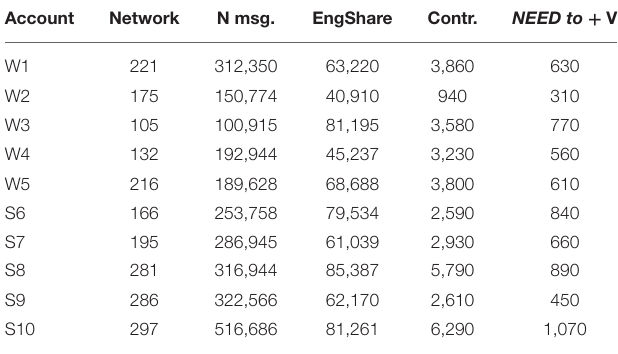
TABLE 2 | Statistics related to the dependent variables (normalized per